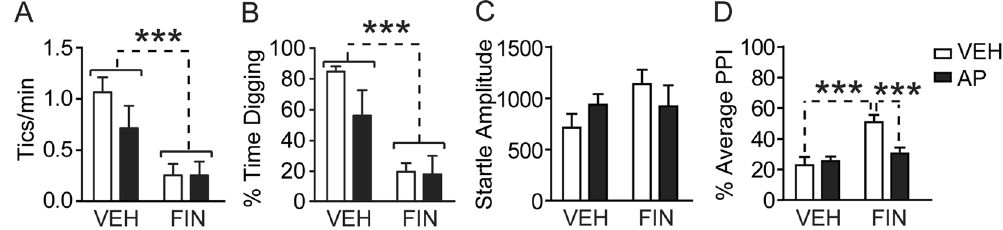
Figure 7. Combined effects of finasteride (FIN; 25 mg/kg, IP) and allopregnanolone (AP; 15 mg/kg, IP) on behavioral phenotypes related to Tourette syndrome in D1CT-7 mice. Data are shown as means ± SEM. *** P < 0.001 for comparisons indicated by dashed lines. Main effects for genotype are indicated as comparisons between brackets. N = 8/group. Abbreviations: VEH, vehicle; PPI, prepulse inhibition. For further details, see